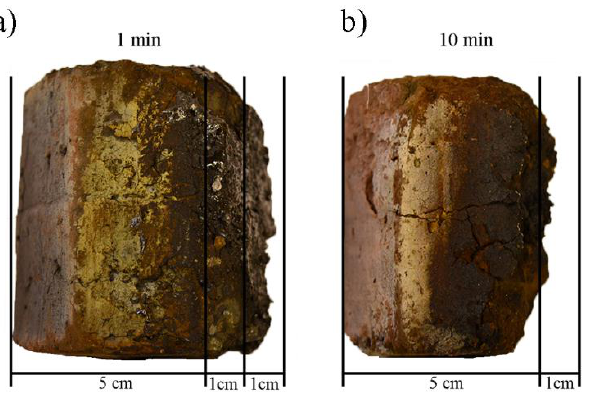
Figure 6. Photographs of the briquettes of Table 4 after contact with hot metal at 1350 ◦ C for ( a ) 1 min, and ( b ) 10 min [30].